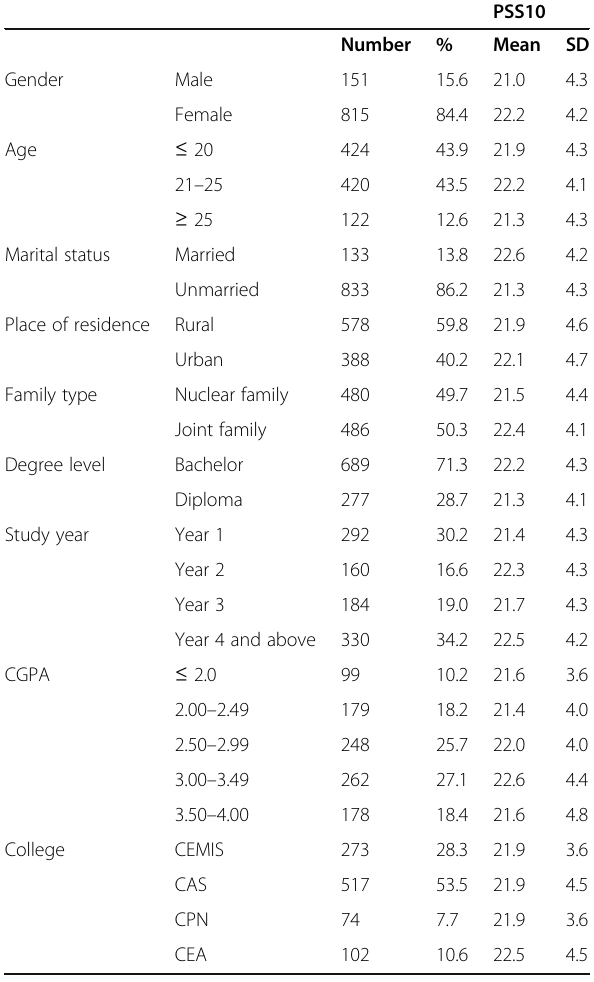
Table 1 Demographic characteristics of the respondents